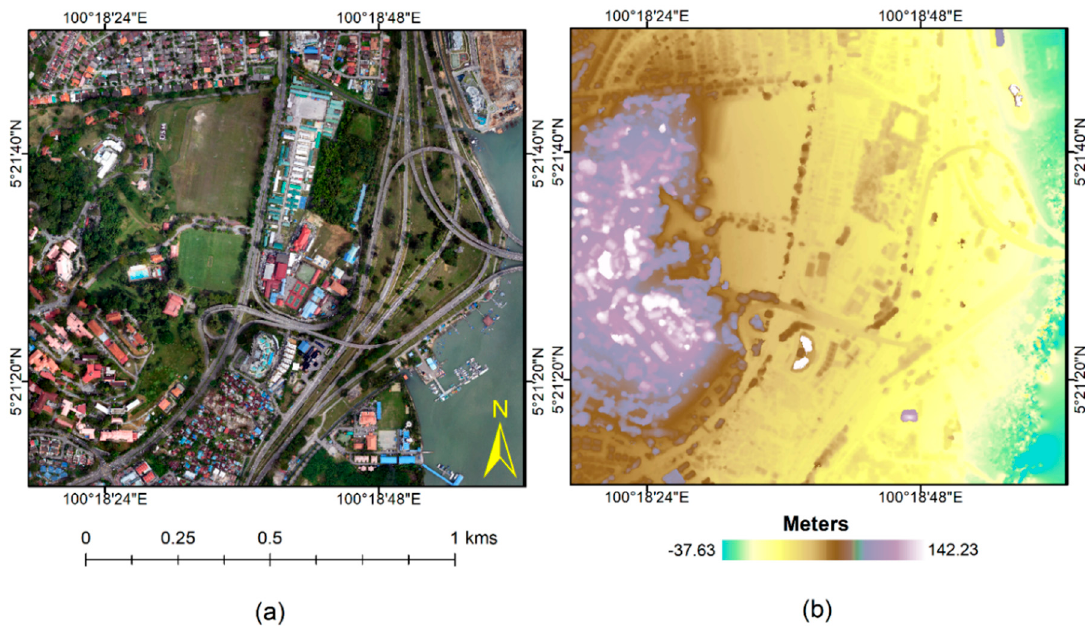
Figure 1. The unmanned aerial vehicle (UAV) datasets used in this work: ( a ) the orthomosaic image and ( b ) the constructed digital surface model (DSM).